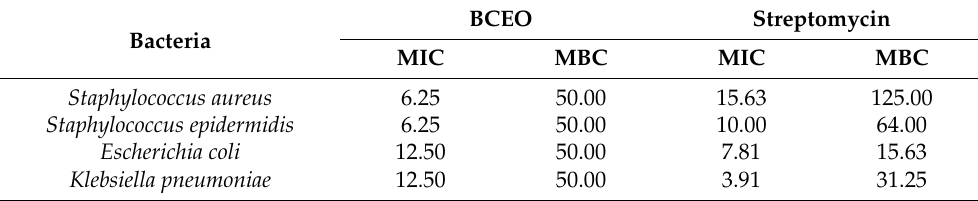
Table 3. Minimum inhibitory concentration (MIC) and minimum bactericidal concentration (MBC) of BCEO and standard antibiotic (streptomycin) against four pathogenic bacteria